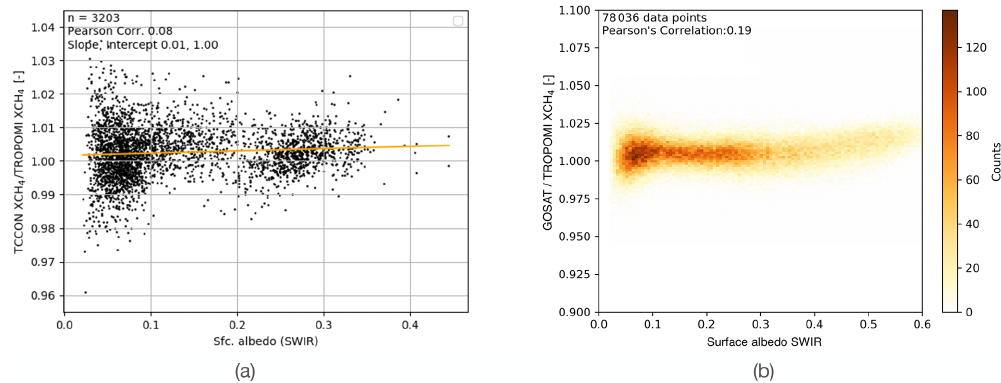
Figure 6. Ratio of daily XCH 4 measurements by (a) TCCON and TROPOMI and (b) GOSAT and TROPOMI as a function of retrieved surface albedo in the SWIR spectral range. Data for the period 1 December 2018–31 December 2019 are